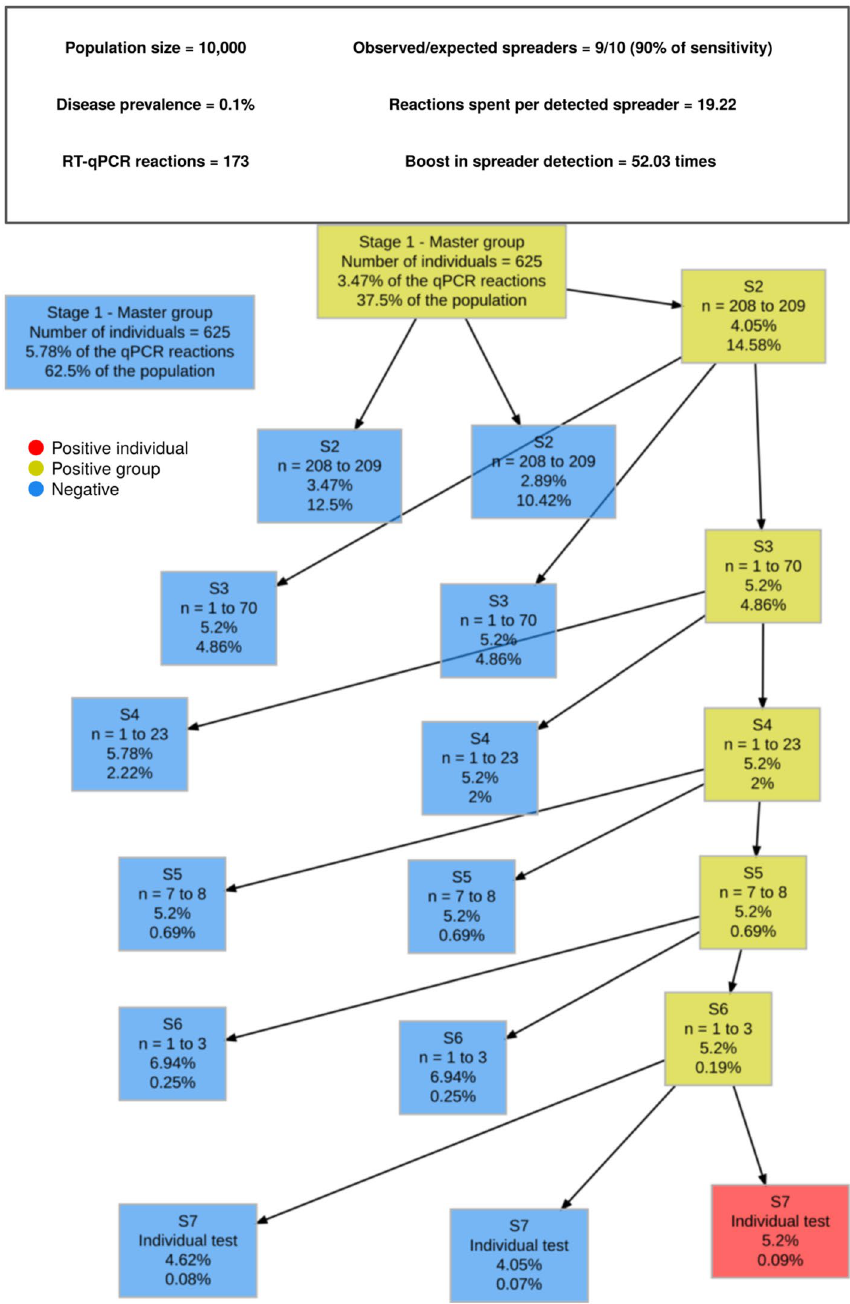
Figure 5. A diagram of a simulated scenario belonging to the multi-stage OTC at 0.1% of prevalence, which has the boost in spreader detection closest to all iterations average. The header gives basic information about the population size used in simulation, prevalence, number of reactions used in total and basic statistics. The majority of the population (i.e. 62.5% ) will retrieve as negative in the first stage (i.e. master group), 85.42% in second and progressively smaller percentages in subsequent stages. This testing configuration will require seven states to reach individual testing in a